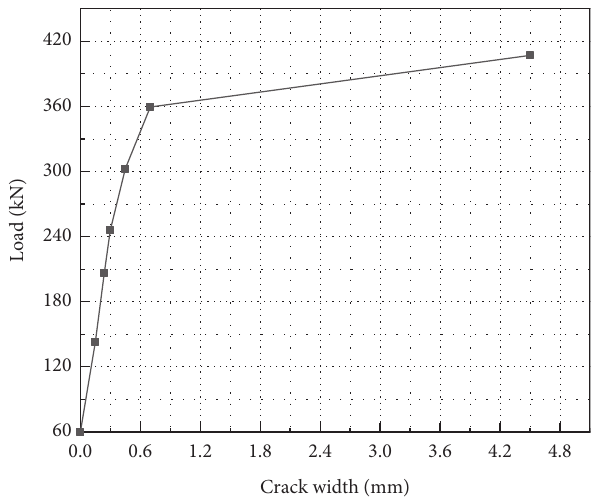
Figure 16: Load-crack width curve of the major